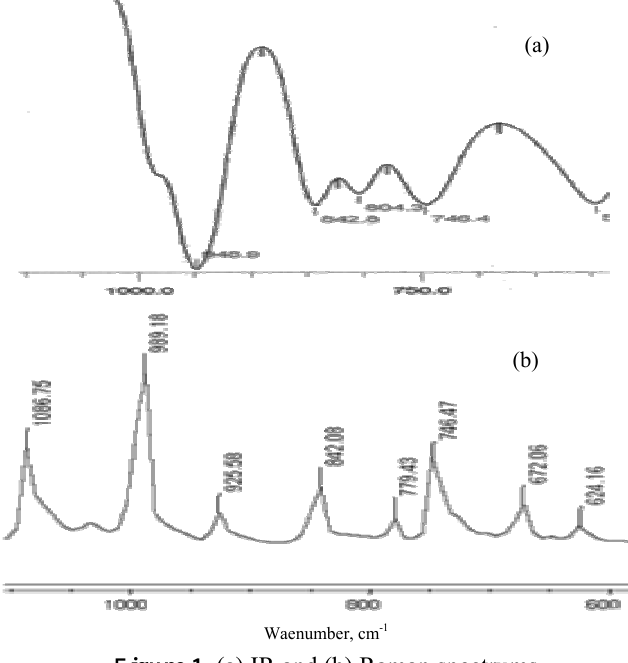
Figure 1. (a) IR and (b) Raman